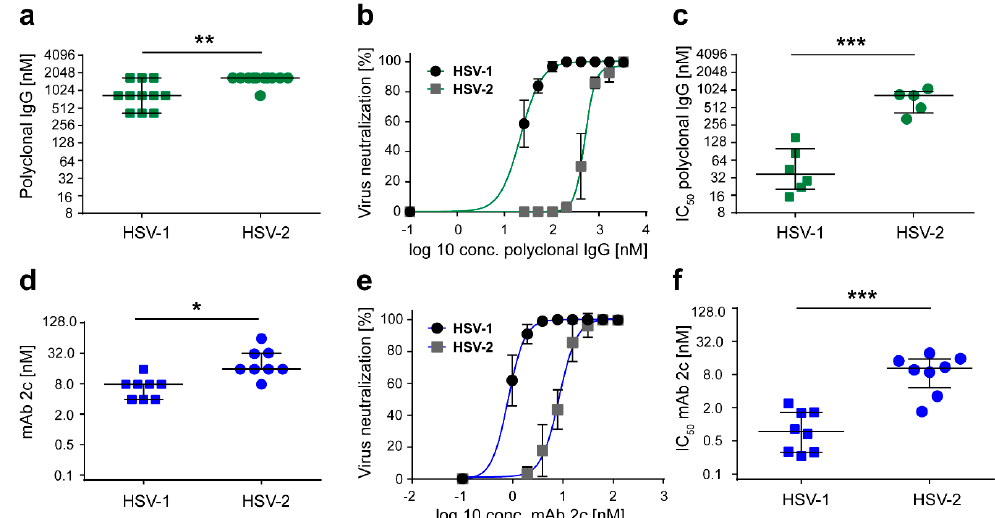
Figure 1. Herpes simplex virus (HSV)-2 withstands higher antibody concentrations before full in vitro neutralization is achieved. Neutralizing activity of ( a ) polyclonal IgG (0 to 3333 nM; n = 11) and ( d ) mAb 2c (0 to 125 nM; n = 8) against a defined viral load of 100 TCID 50 HSV-1 F and HSV-2 G was determined. Data are displayed as median ± SD. ( b , c , e , f ) IC 50 values of polyclonal IgG and mAb 2c against HSV-1 and HSV-2 infection were evaluated by endpoint dilution assays. Vero cells were infected with 100 TCID 50 of HSV-1 GFP or HSV-2 GFP, and treated with serial dilutions of polyclonal IgG (0 to 33,330 nM; HSV-1 n = 6, HSV-2 n = 5) or mAb 2c (0 to 125 nM; n = 8). ( b , e ) Representative dose response curves are displayed as mean ± SD. IC 50 values of ( c ) polyclonal IgG and ( f ) mAb 2c regarding HSV-1 GFP and HSV-2 GFP infection were calculated. Data sets were statistically evaluated using an unpaired t -test and significant changes are indicated by asterisks (* p < 0.05, ** p < 0.01, *** p < 0.001).